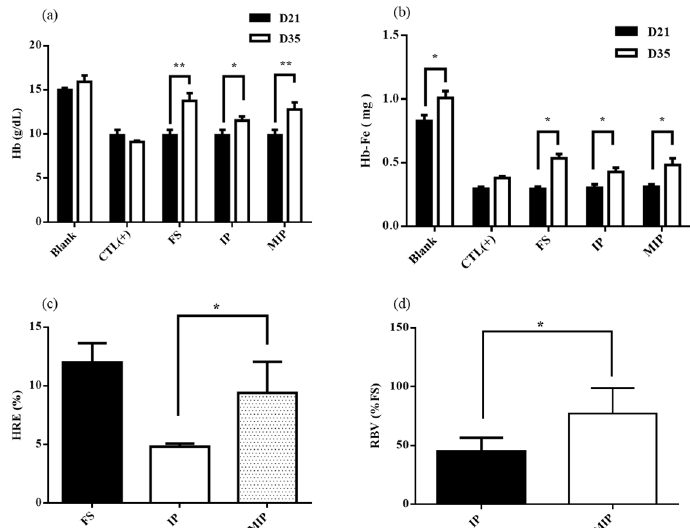
Figure 9. Hemoglobin and iron responses in the rat hemoglobin regeneration assay after 14 days: ( a ) Hb, ( b ) Hb-Fe, ( c ) HRE, and ( d ) RBV. Blank: Normal diet; CTL( + ): AIN-93G diet; FS: AIN-93G + 24 mg / kg FeSO 4 · 7H 2 O; IP: AIN-93G + 24 mg / kg commercial iron particles; MIP: AIN-93G + 24 mg / kg mesoporous iron particles. All data are presented as mean ± SD ( n = 6). * p < 0.05; ** p <